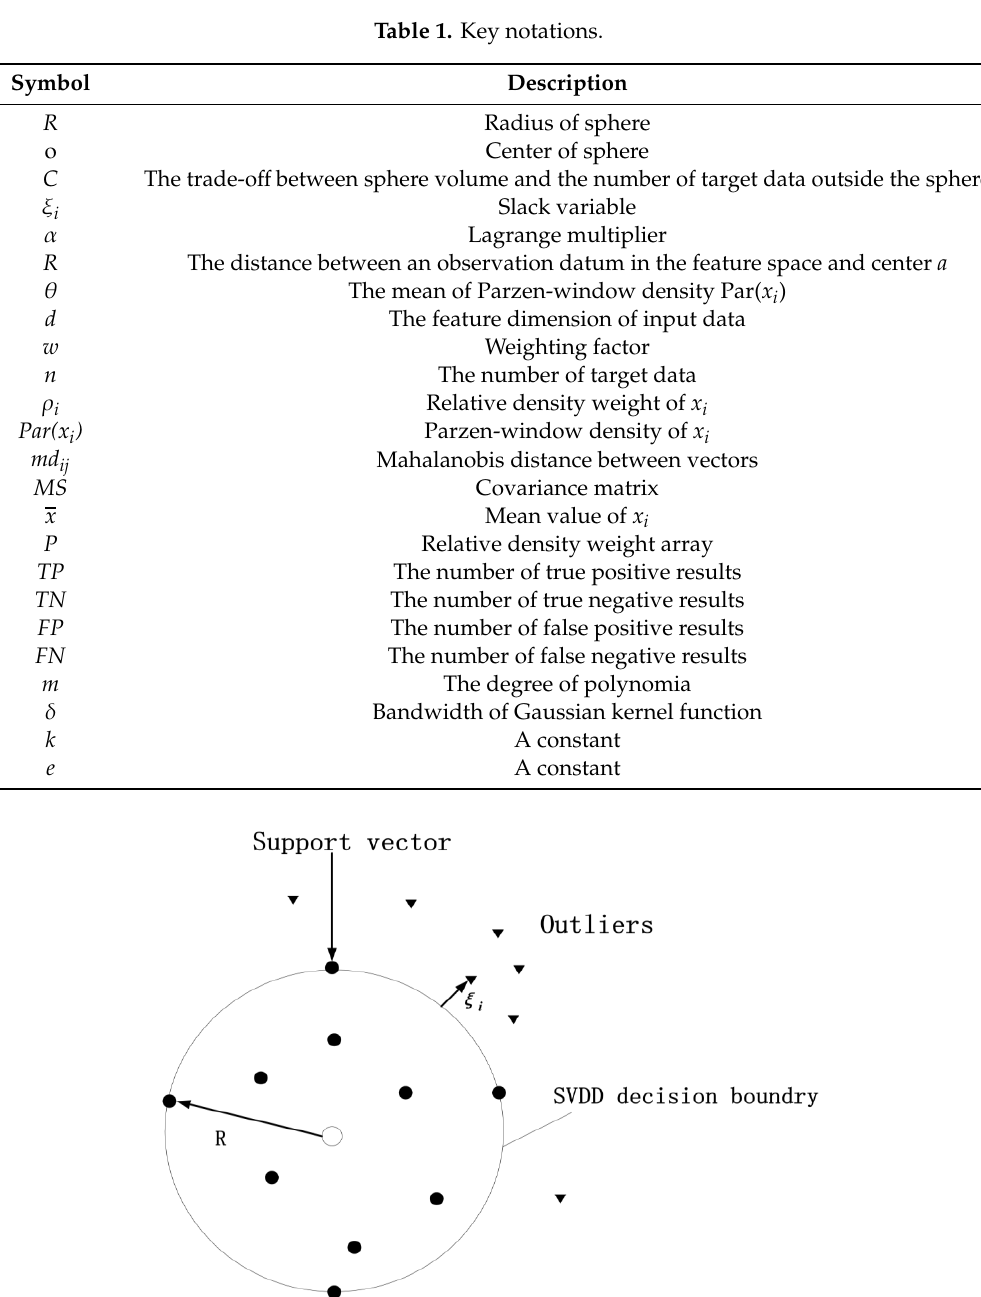
Figure 1. Illustration of support vector data description (SVDD) in feature space for outlier detection.